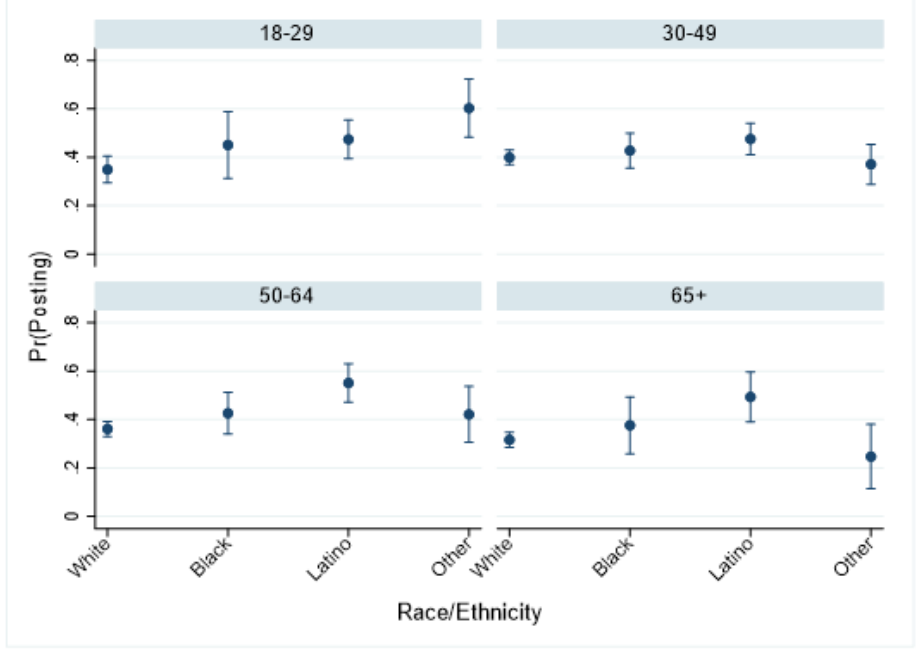
Figure 3. Predicted probabilities of posting (95% CI) for each age group by race and ethnicity. Pr(Posting): probability of